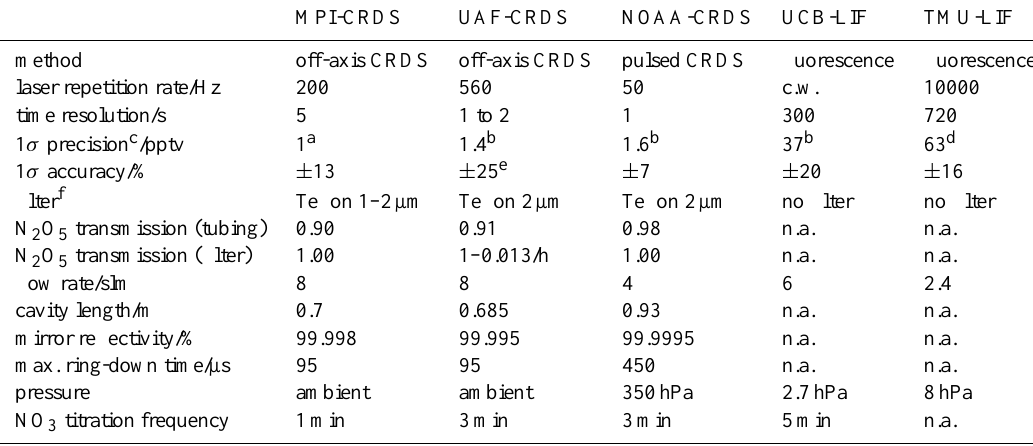
Table 1. Performance and properties of instruments detecting N 2 O 5 during